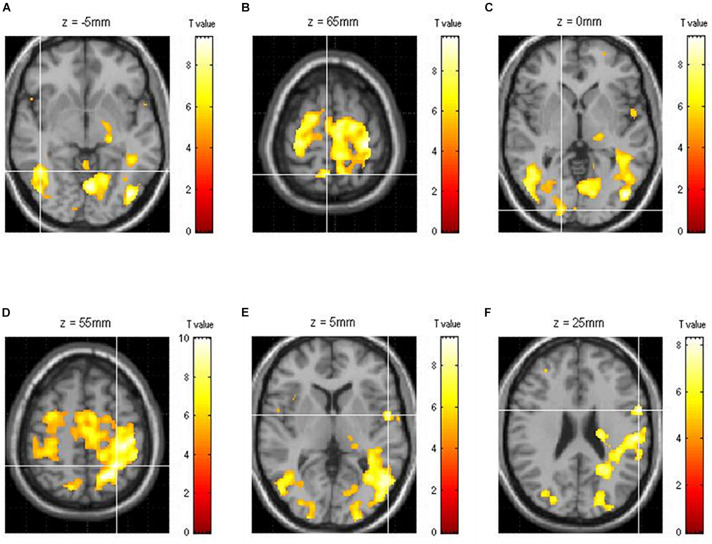
Functional brain map showing the average of all subjects obtained through group analysis. The three right [(A) ITG, inferior temporal gyrus; (B) PCu, precuneus; (C) LiG, lingual gyrus] and left [(D) IPL, inferior parietal lobule; (E) STG, superior temporal gyrus; (F) IFG, inferior frontal gyrus] hemispheric areas with the highest z-scores during driving.